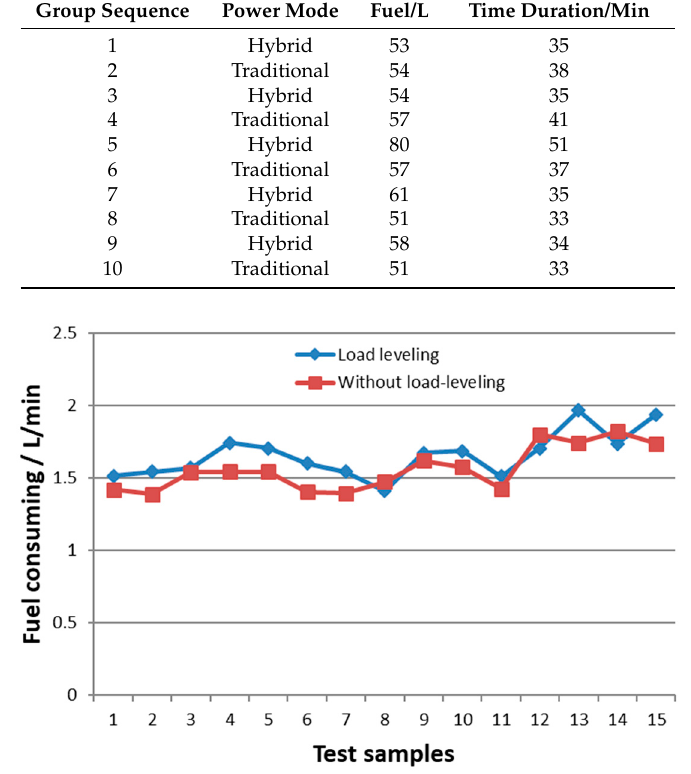
Table 2. Fuel consumption comparison of two kinds of power operation modes.